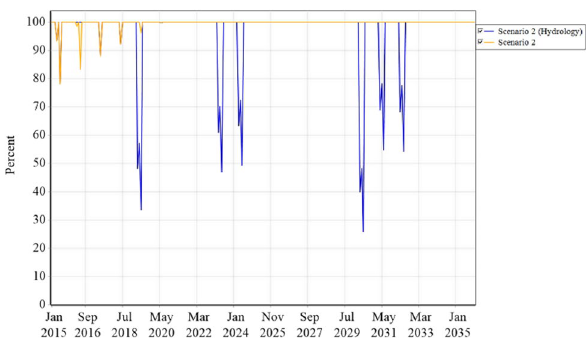
Fig. 8 Changes in satisfaction degree of greening demand site in f-mine